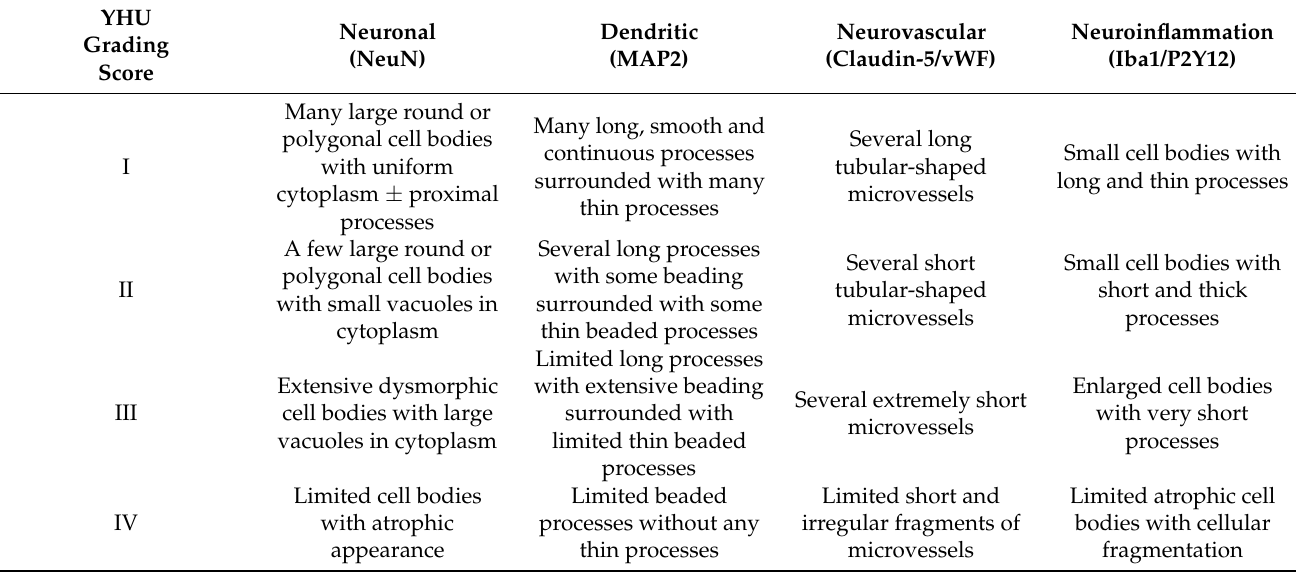
Table 2. Summary of the morphological characteristics obtained from the immunohistological staining of biopsy samples. The Roman numerals in column 1 represent the YHU grading scales presented in Figures 2–5.